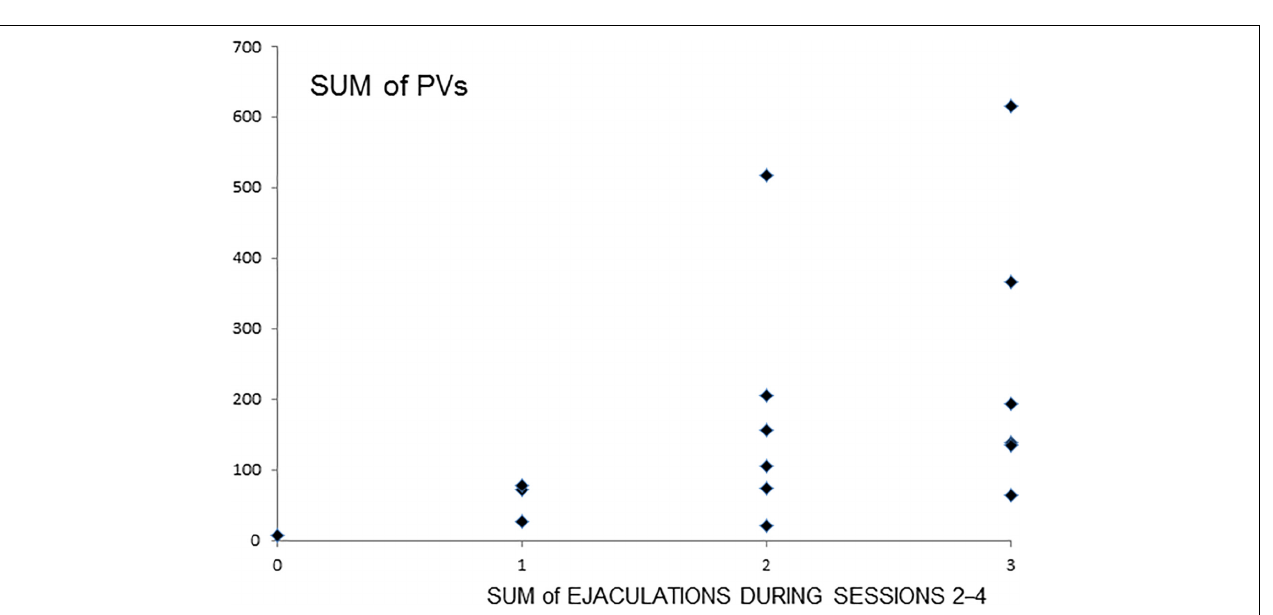
FIGURE 1 | The means number (SE) of PVs during the acquisition of sexual experience. Numbers on the Y axis represent the means value of PVs emitted during subsequent sessions. Statistically significant differences compared with session 1 ( ∗ P < 0.05 and ∗∗ P < 0.01).